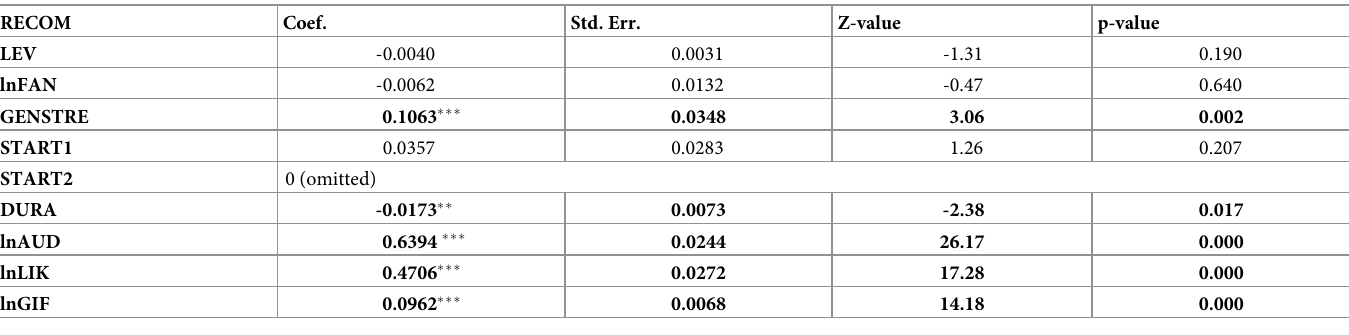
Table 5. Parameter estimates for the Negative Binomial model for the full sample ( N = 1091). RECOM Coef. Std. Err. Z-value LEV -0.0040